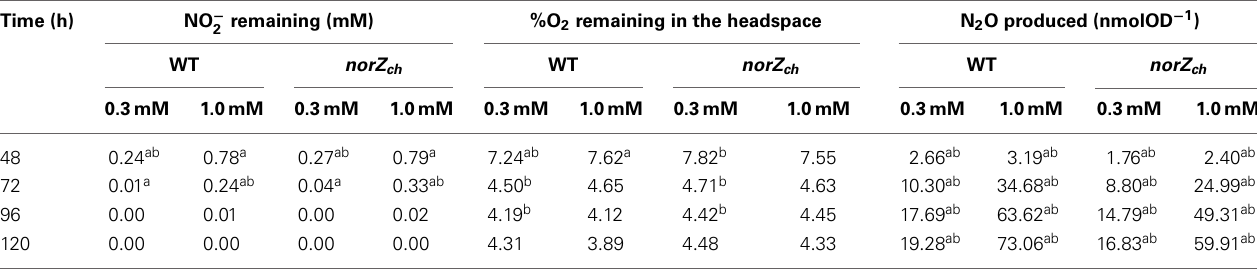
Values represent averages from 5 experiments initiated on different cultures and on different days. N 2 O amounts were normalized to OD of each culture at each time point. Statistically significant differences between treatments were determined by Student’s t-test at p < 0.05 and are designated as follows: a Significant difference between 0.3 and 1mM NaNO 2 treatment groups of wildtype (WT) or norZ ch mutant cultures of S. wittichii RW1 at each time point. b Significant difference between WT and norZ ch mutant S. wittichii RW1 cultures incubated with 0.3mM NaNO 2 or 1mM NaNO 2 .